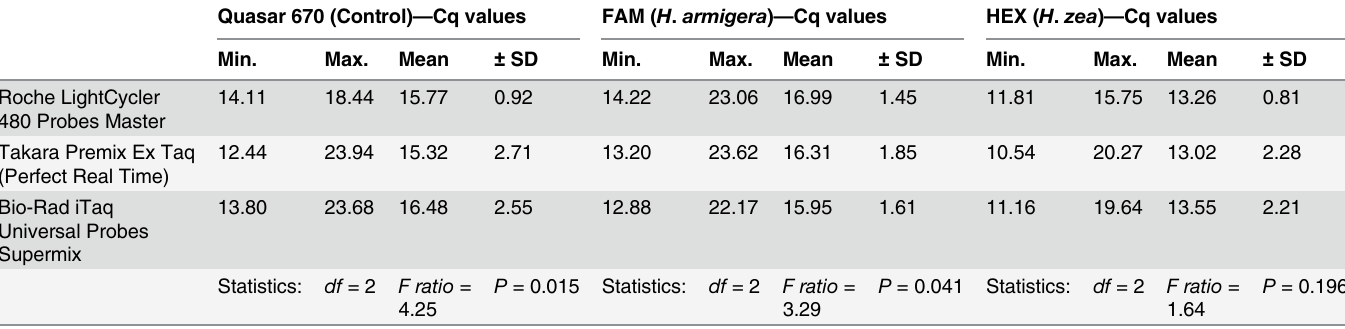
Table 3. Cq values for each probe resulting from testing different real-time PCR master mixes with the triplex assay. ANOVA statistics for compari- sons of each data set are provided in the last row of the table. Quasar 670 (Control) — Cq values FAM ( H . armigera ) — Cq values HEX ( H . zea ) — Cq values Min. Max. Min. Max. Min.